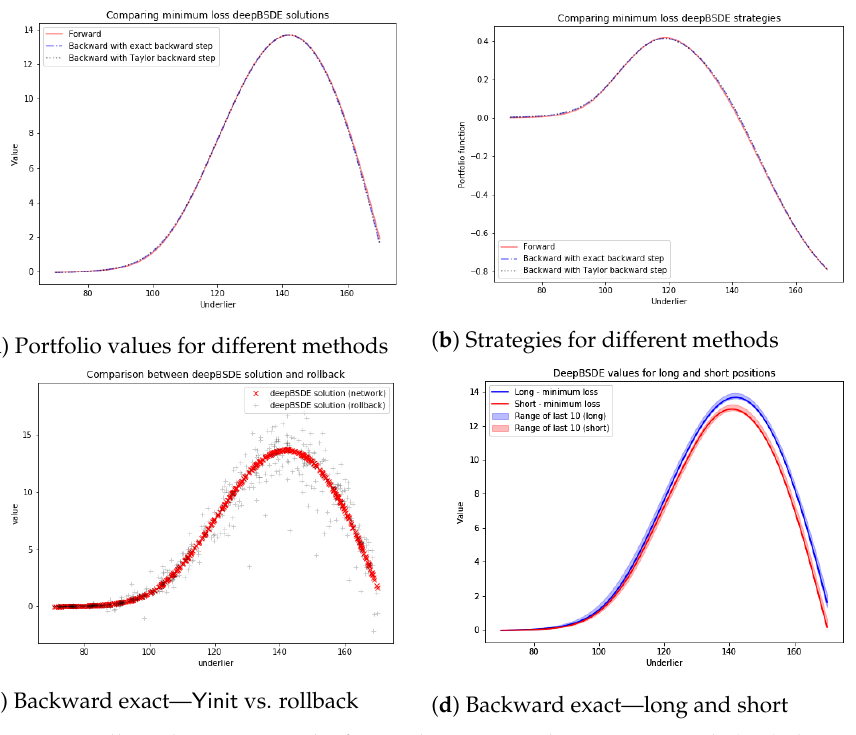
Figure 4. Call combination: results for random X 0 . Batch size 512. Panels ( a – c ) show results for a long position. ( d ) shows results for both long and short